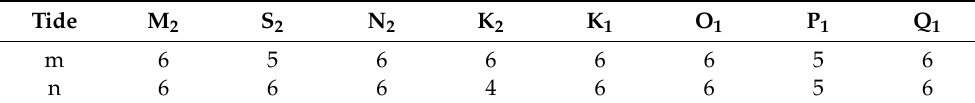
Table 1. The optimal orders of the Chebyshev polynomials for the eight major constituents.